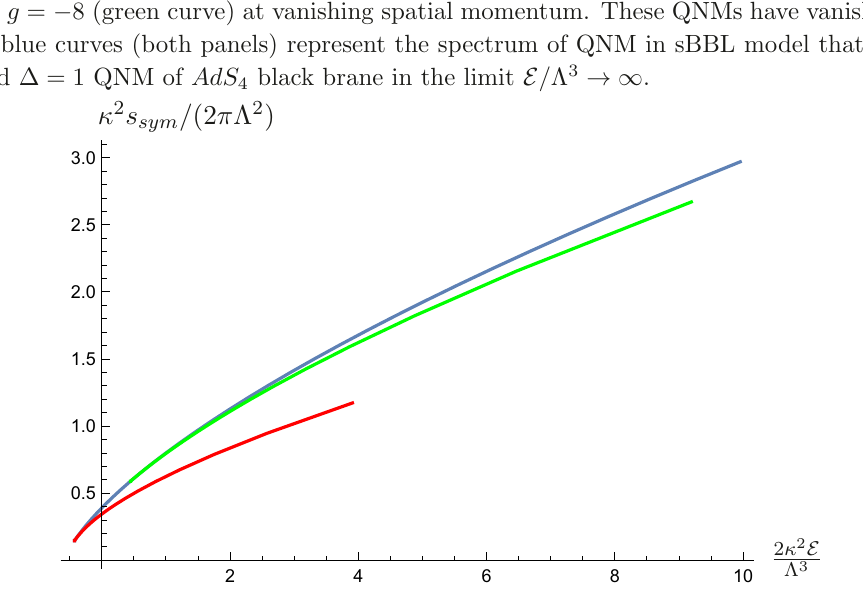
Figure 9 . Phase diagram of sBBL model in microcanonical ensemble. The blue curve represents the symmetric phase of the system; the green and red curves are the exotic phases at g = g = 2 correspondingly, which exist only for −